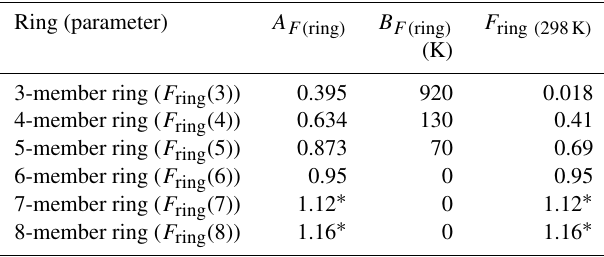
Table 2. The substituent factors, F (X), for alkyl groups, and their temperature dependences described by the term